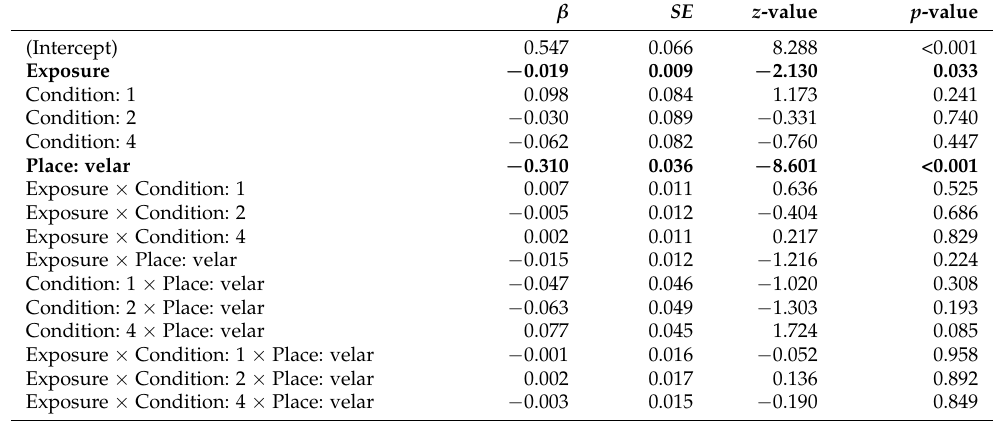
Table A1. Cont . ( c ) Condition 3 (unrelated task) as reference